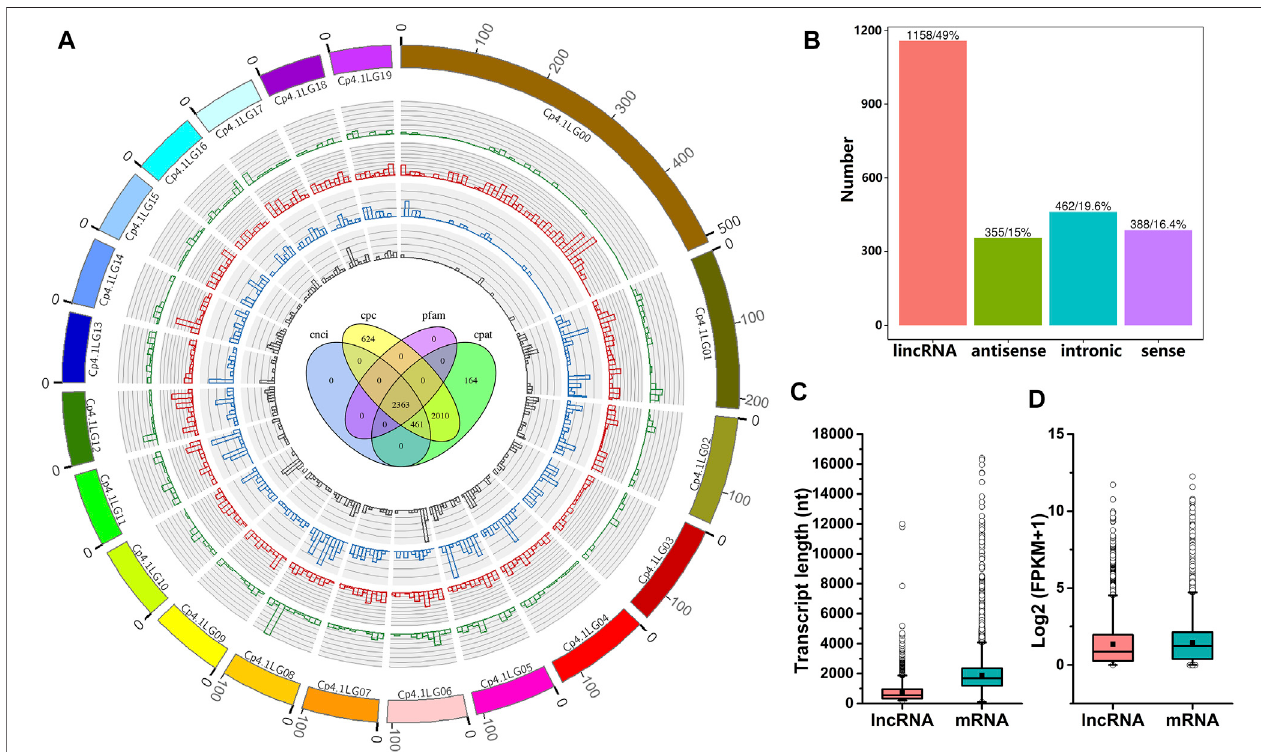
FIGURE 2 | Characteristics of C. pepo lncRNAs. (A) Distribution of lncRNAs along C . pepo chromosomes. The scale unit of chromosomes is 10 5 bp. Green represents sense lncRNAs, red represents lincRNAs, blue represents intronic lncRNAs and grey represents antisense lncRNAs. Venn diagram in the center shows the numberoflncRNAspredictedbyevaluatingprotein-codingpotentialintheCodingPotentialCalculator(CPC),Coding-Non-Coding-Index(CNCI),PfamScan(Pfam),and Coding Potential Assessment Tool (CPAT). (B) Classi fi cation of C. pepo lncRNAs according to their genomic positions. (C,D) Comparisons between lncRNA and mRNA. lncRNAs are shorter (C) and expressed at lower levels (D) than protein-coding